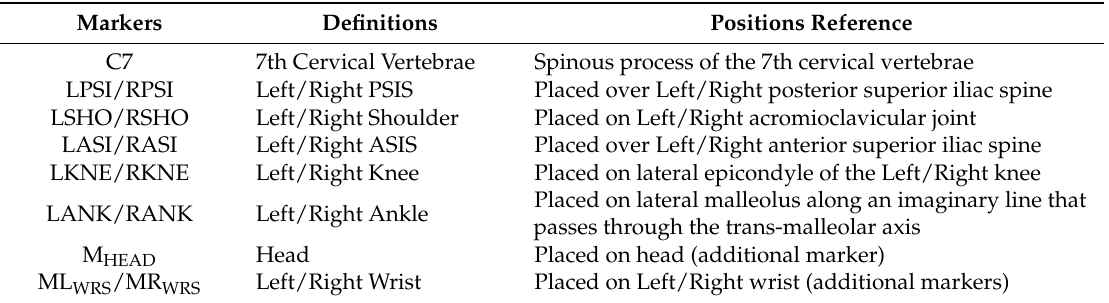
Figure 4. Details of the marker set placement positions. Table 1. Markers of the optoelectronic system for the accuracy